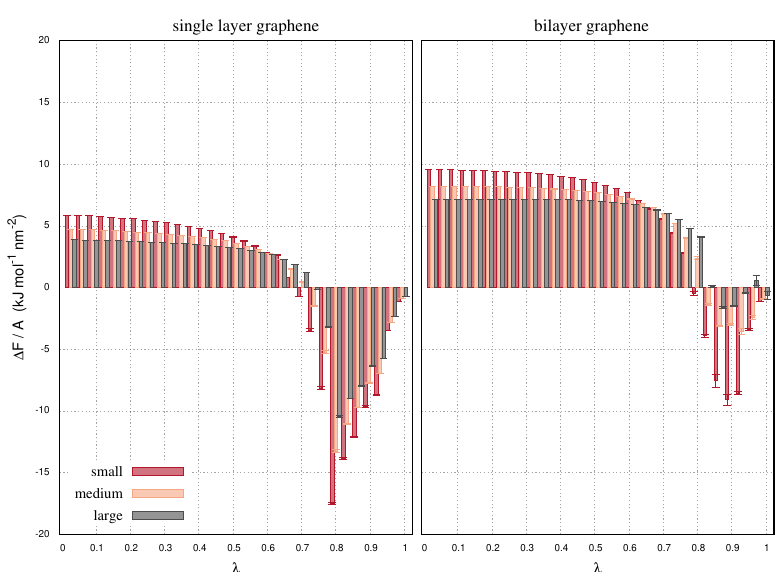
Figure 2. Free energy derivatives as a function of the decoupling parameter, λ , for the single and bilayer graphene samples with small, medium and large size. The free energy values are normalized by the area size of the